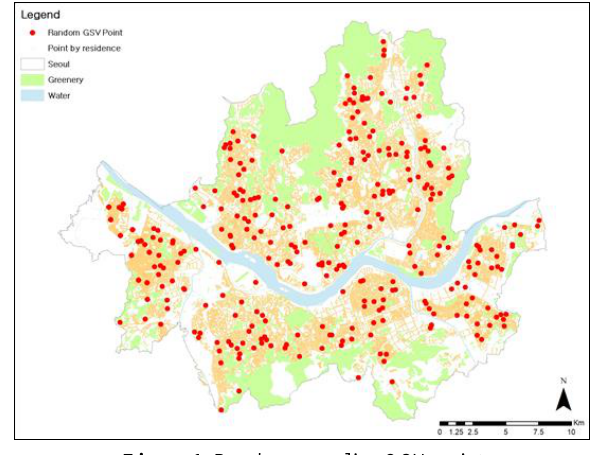
Figure 1. Random sampling GSV